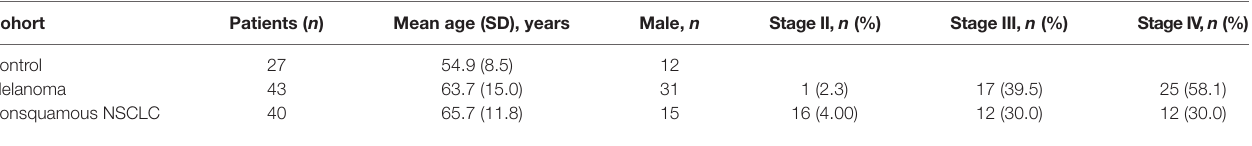
Table 1 | Patient characteristics and